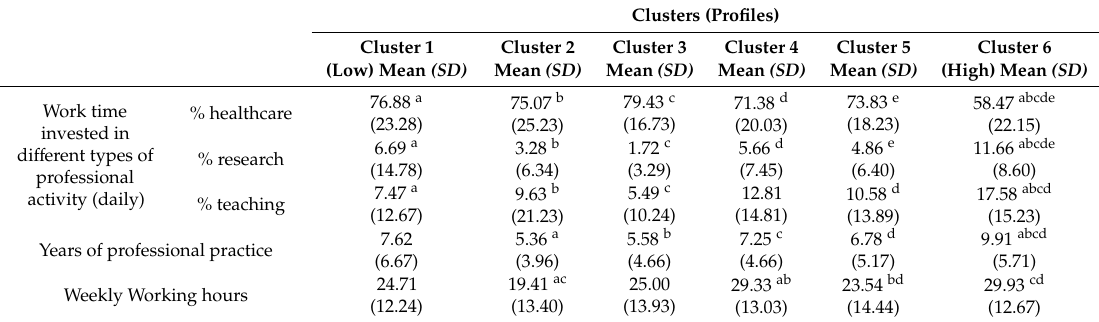
Table5. One-wayANOVAwithpost-hocBonferroniteststocompareclusters(profiles)withprofessional practice related variables.